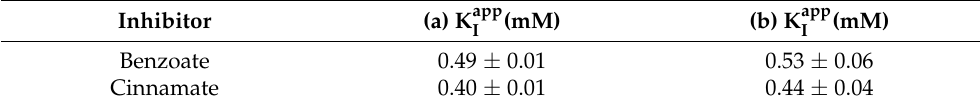
(mM) obtained from the analysis of